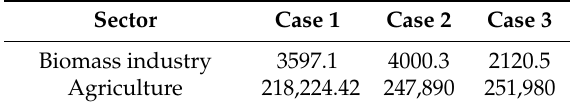
Table 3. Maximal profits for the biomass power generation industry and agriculture in the three cases (million